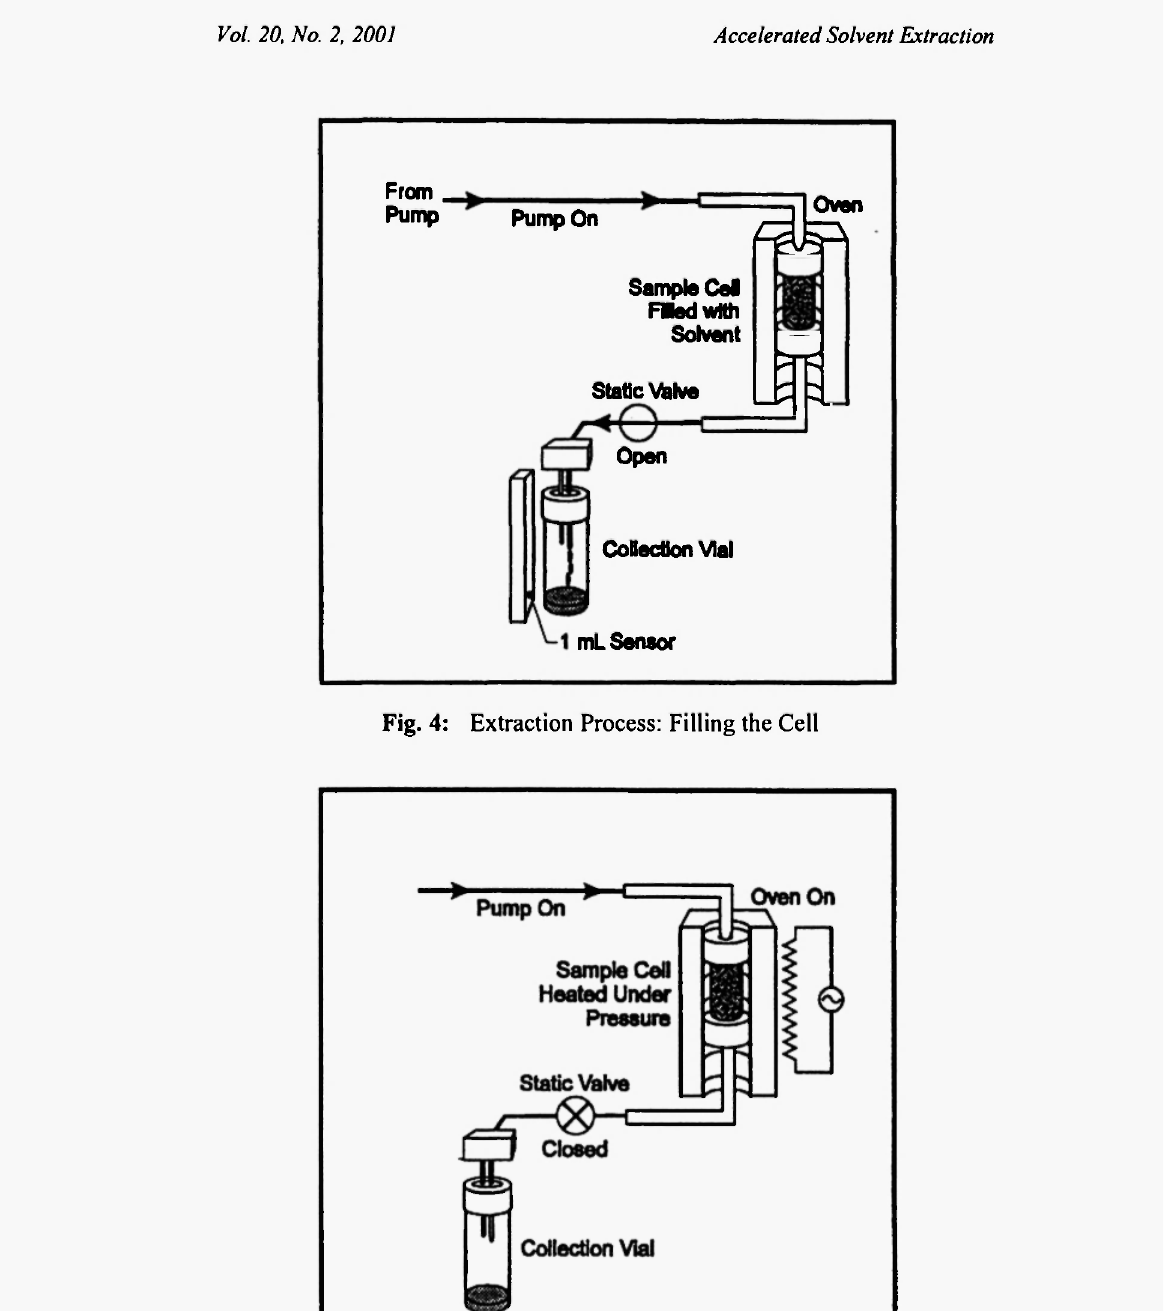
Fig. 5: Extraction Process: Heating and